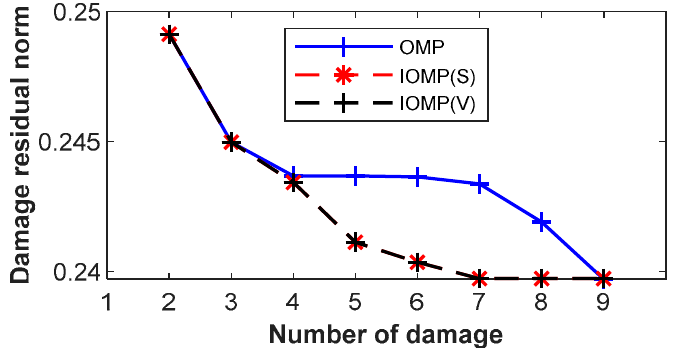
Figure 12. Contrast with sparsity in frame Experiment.